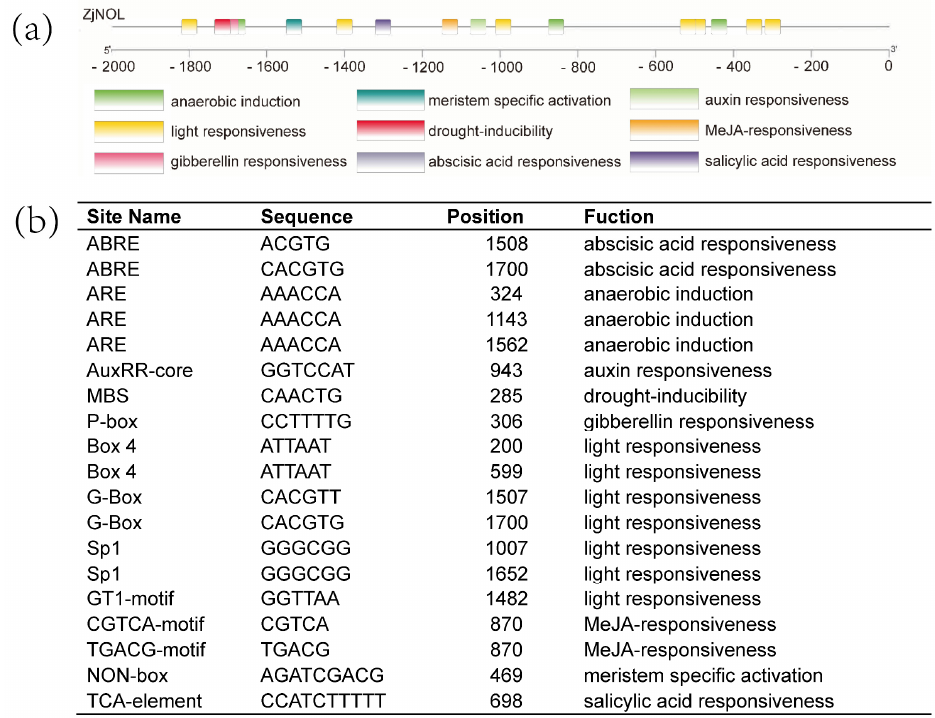
Figure 2. Analysis of upstream sequence of ZjNOL gene. ( a ) Cis-acting elements upstream of ZjNOL gene. ( b ) List of predicted binding sites for the transcription factors upstream of ZjNOL gene. 2.2. ZjNOL Expression Profiles and Expression Analysis of AsZDS, AsNCED, AsCLH1 and AsNYC Induced by Dark Real-time PCR was used to detect ZjNOL expression patterns in various tissues and developmental phases. The results revealed that ZjNOL was expressed in root, stem, and leaf tissues, with leaf expression being substantially higher (Figure 3a). Among all the de- tected tissues, ZjNOL was expressed highest in mature leaves, which was 9.67 and 12.61 times of those in young and fast-growing leaves, respectively (Figure 3b). ZjNOL expres- sion was up-regulated by ABA or SA (Figure 3c–f). The level of ZjNOL expression was reduced after MeJA treatment (Figure 3c–f). The expression level of ZjNOL rose and then dropped after gibberellic acid (GA3) therapy. The expression of ZjNOL dropped initially and then rose in response to salt and drought treatments. ZjNOL may be involved in leaf growth, stress, and hormone response.